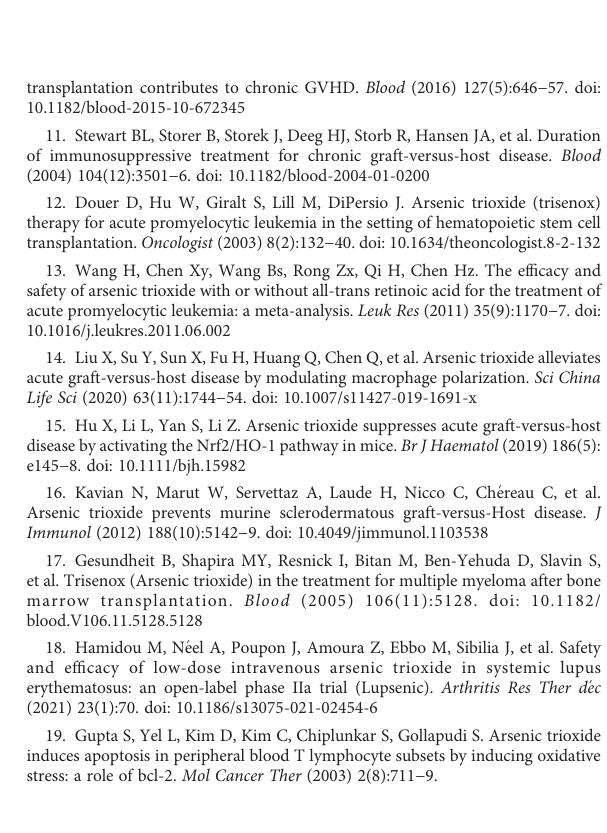
SUPPLEMENTARY TABLE 1 List of primer sequences used for real-time quantitative polymerase chain